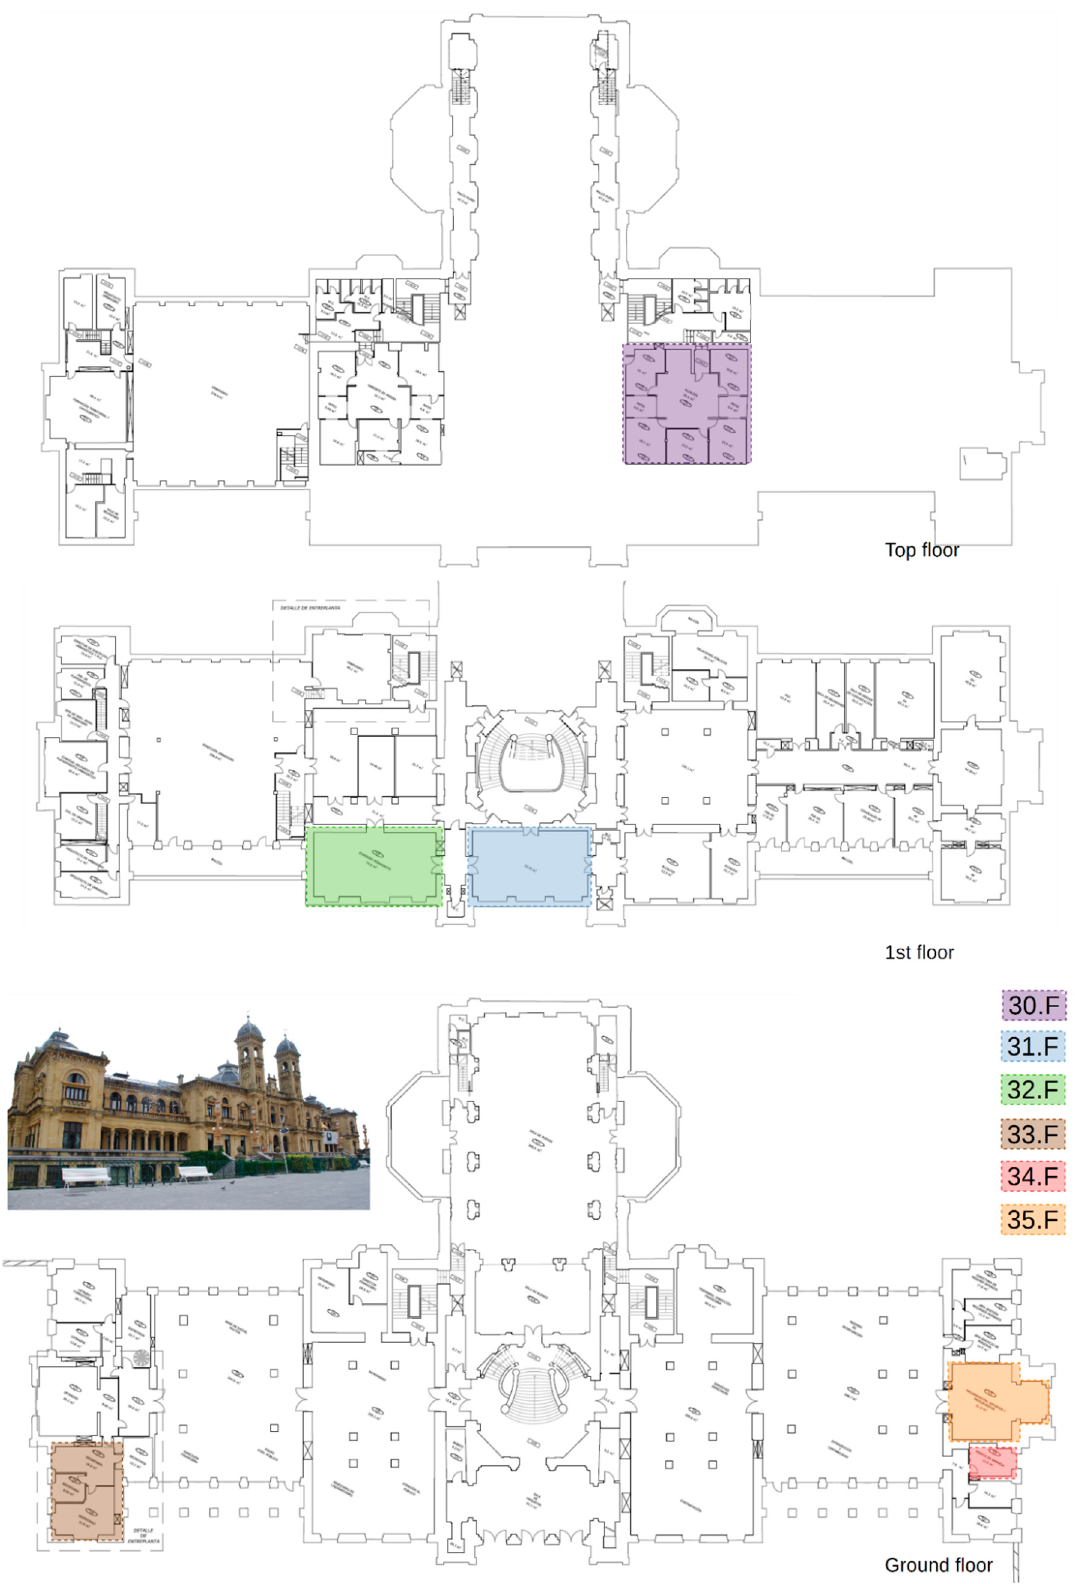
Figure A6. Floor plans of the blower door tests performed in the City-Council of Donostia-San Sebastián case study.